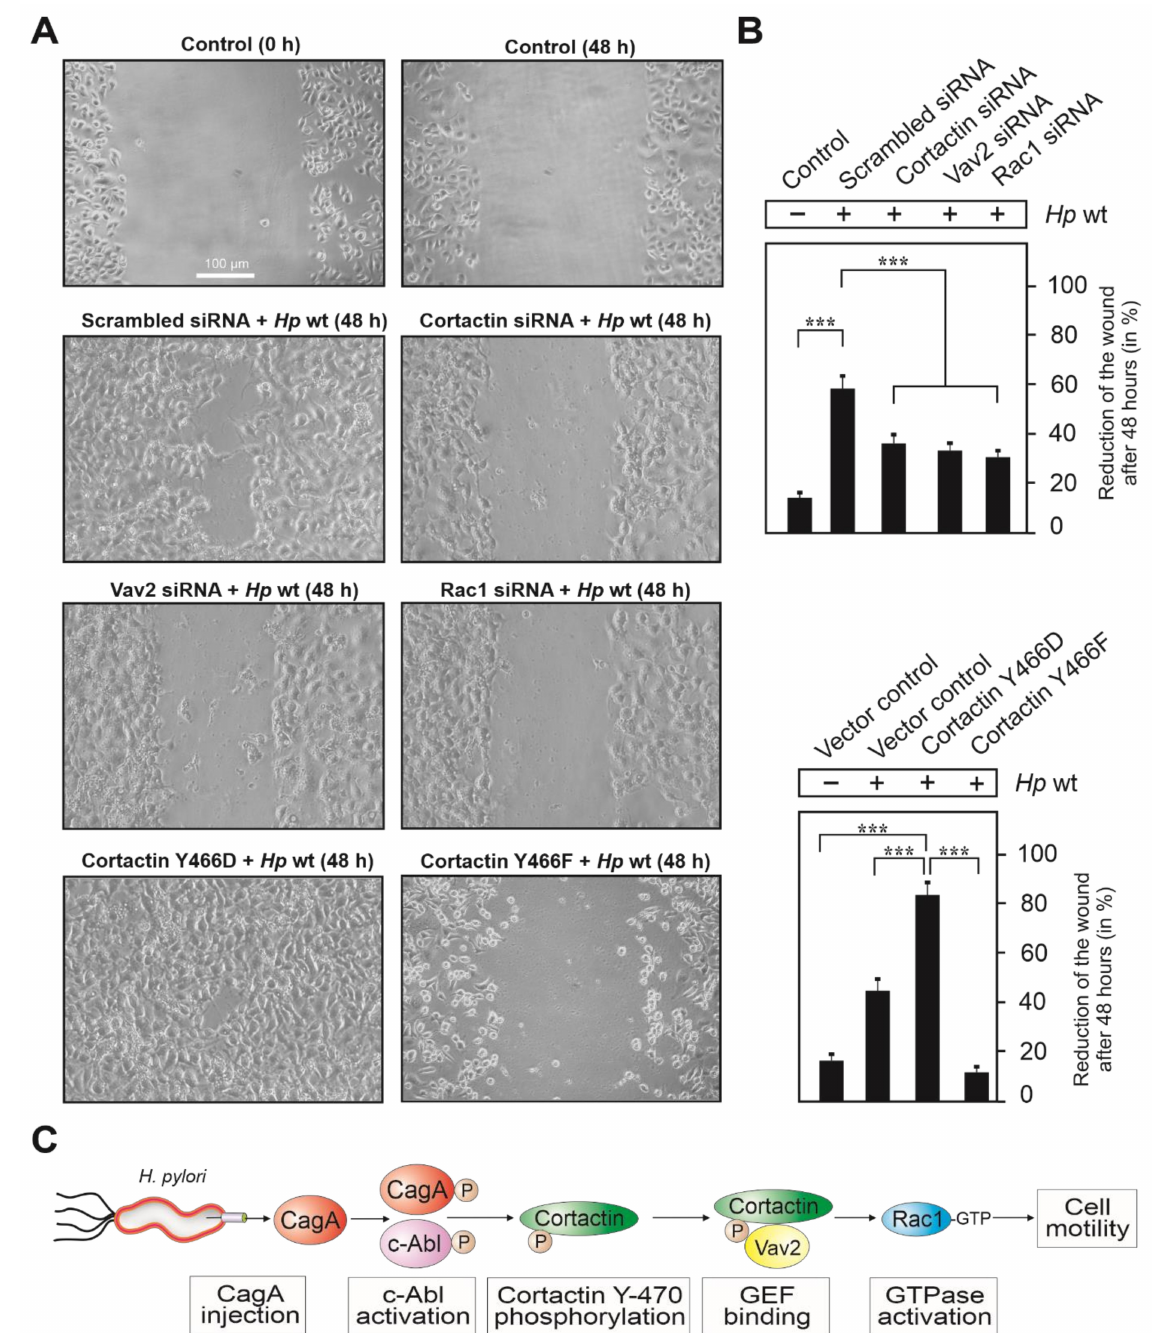
Figure 7. Importance of cortactin, Vav2 and Rac1 expression as well as cortactin tyrosine phosphorylation for AGS cell migration during infection with H. pylori . ( A ) Confluent cell monolayers of AGS cells were transfected with siRNAs against cortactin, Vav2 and Rac1, scrambled siRNAs or Cortactin-Y466D, Cortactin-Y466F and vector control constructs. Then, cells were wounded using a pipette tip, followed by infection with H. pylori for 48 h (middle and bottom) or treatment with PBS buffer as control (top). All images at 100 × magnification, scale bar represents 100 µ m. ( B ) The areas following wound closure were measured after 48 h of infection. Error bars represent +/ − standard deviation (SD). The results are from three independent experiments. p -values of ≤ 0.001 (***) were considered as statistically highly significant. ( C ) Proposed signal transduction cascade of injected CagA leading successively to activation of Abl kinase, phosphorylation of cortactin at Y-470, Vav2 binding, Rac1 GTPase activation and cell